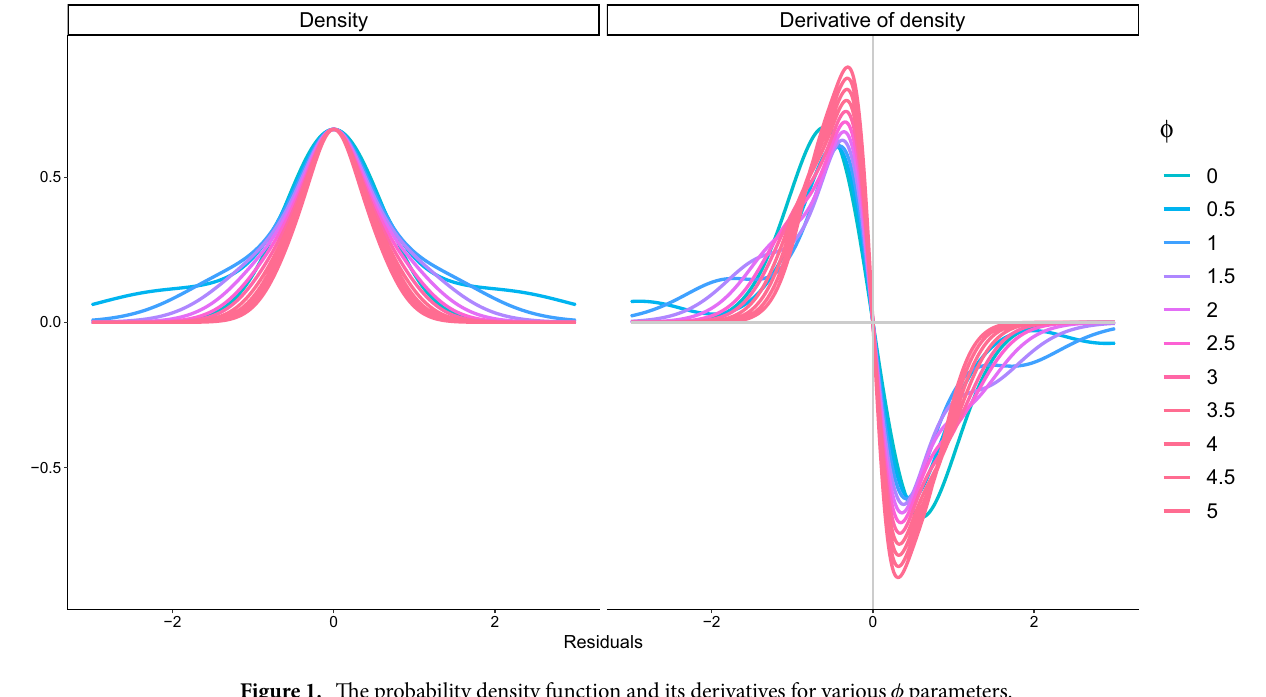
Figure 1. The probability density function and its derivatives for various φ